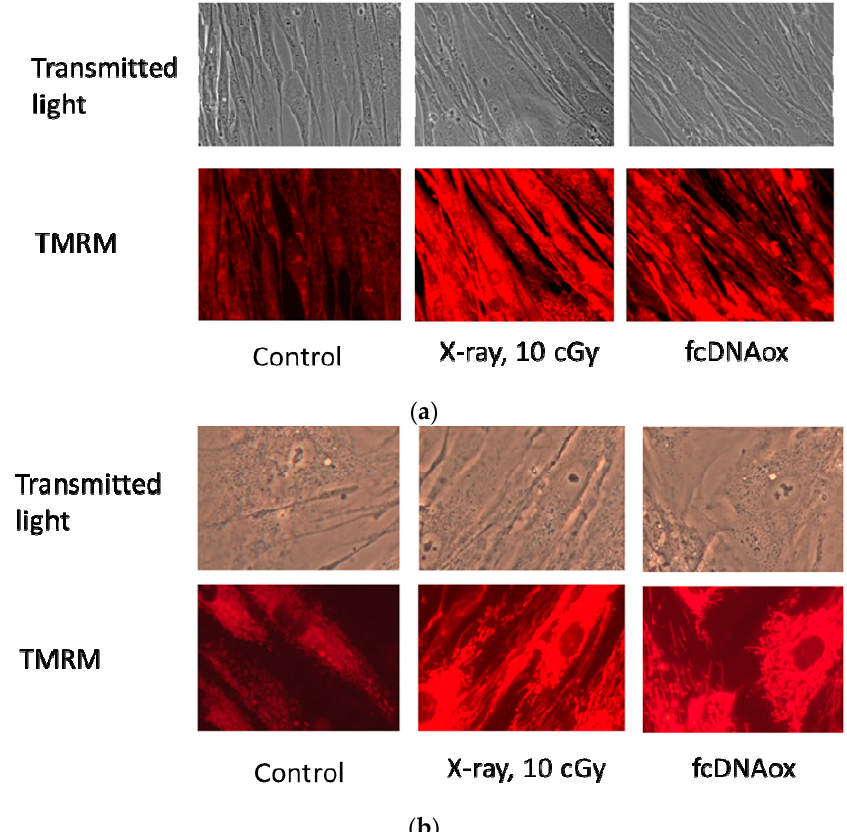
Figure 2. Mitochondrial potential in MSCs one hour after exposure to X-ray radiation (10 cGy) or oxidized cfDNA (50 ng/mL); ( a ) the magnification is 40×, ( b ) the magnification is 100×.